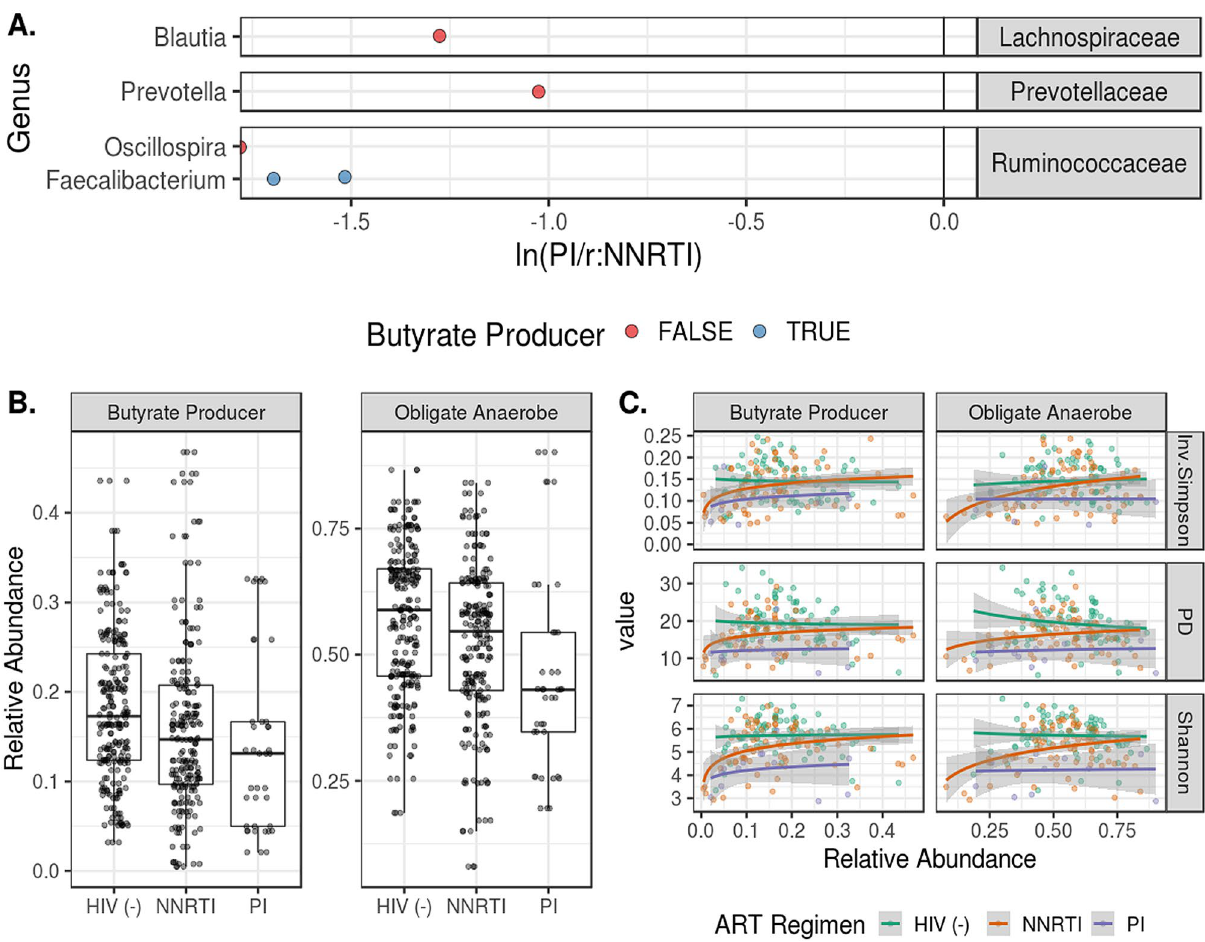
Figure 6. Differential abundance of ASVs and microbiome function by ART regimen. Differentially represented ASVs in the HIV-positive NNRTI and PI/r cohorts were identified via paired, Wilcoxon tests. Mean relative abundances were calculated for these ASVs for the NNRTI and PI/r cohorts. In ( A ), the log-ratio of those mean abundances are plotted on the x axis, with ASVs less abundant in the PI/r cohort having a ratio less than 0. ASVs are grouped at the family level, and the genus-level taxonomic assignment is given on the y axis. ASVs with genus-level taxonomic assignments were filtered against the “List of Prokaryotes according to their Aerotolerant or Obligate Anaerobic Metabolism” and were assigned a binary value for predicted butyrate production and obligate anaerobic growth. Relative abundances for ASVs predicted to have these traits are shown in ( B ). There was a trending difference relative abundances of butyrate producers and obligate anaerobes by HIV status (p = 0.06). ( C ) Depicts the log-linear relationships between the relative abundance of these traits and the corresponding alpha diversity (p <